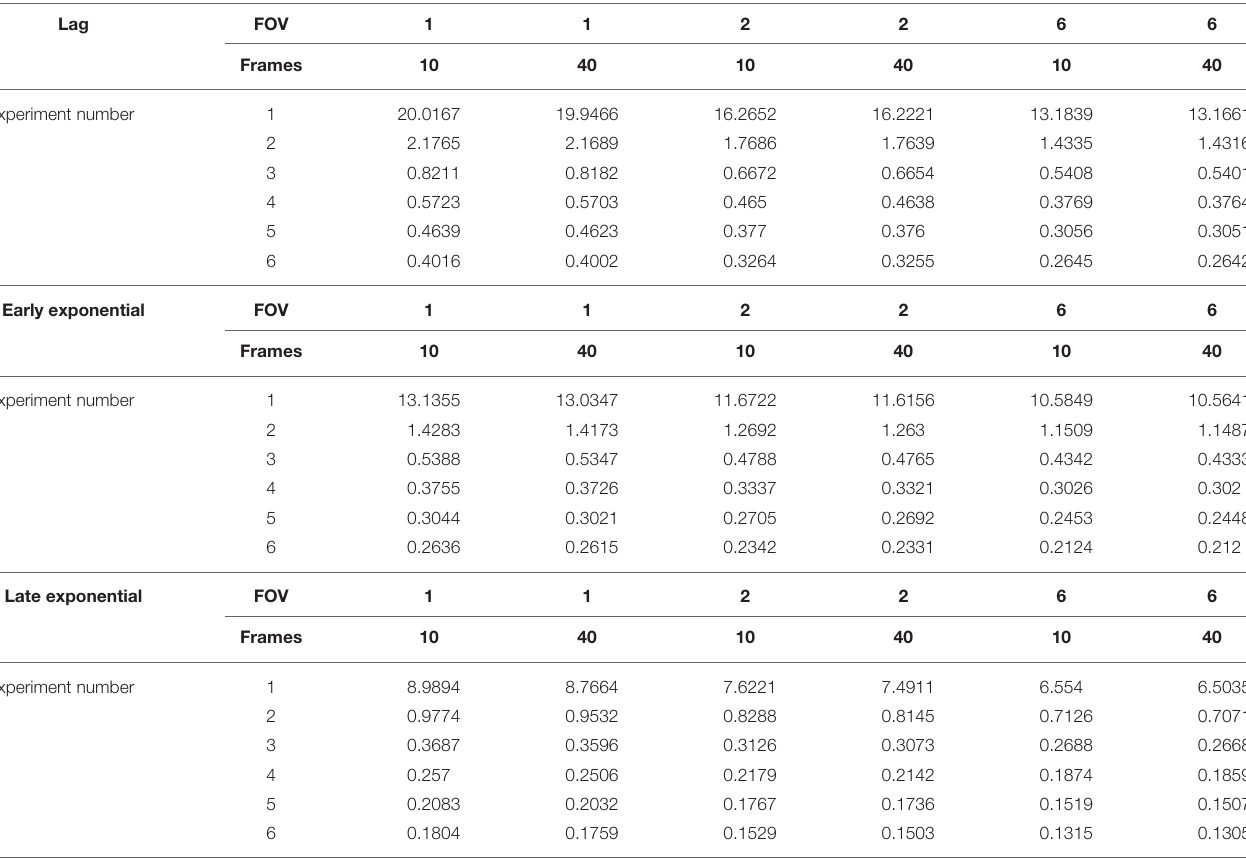
TABLE 2 | Expected margin of error for a one-sided 95% confidence interval for the mean log 10 (GFP area) at different phases of growth and a variety of experimental parameters for untreated controls. Lag